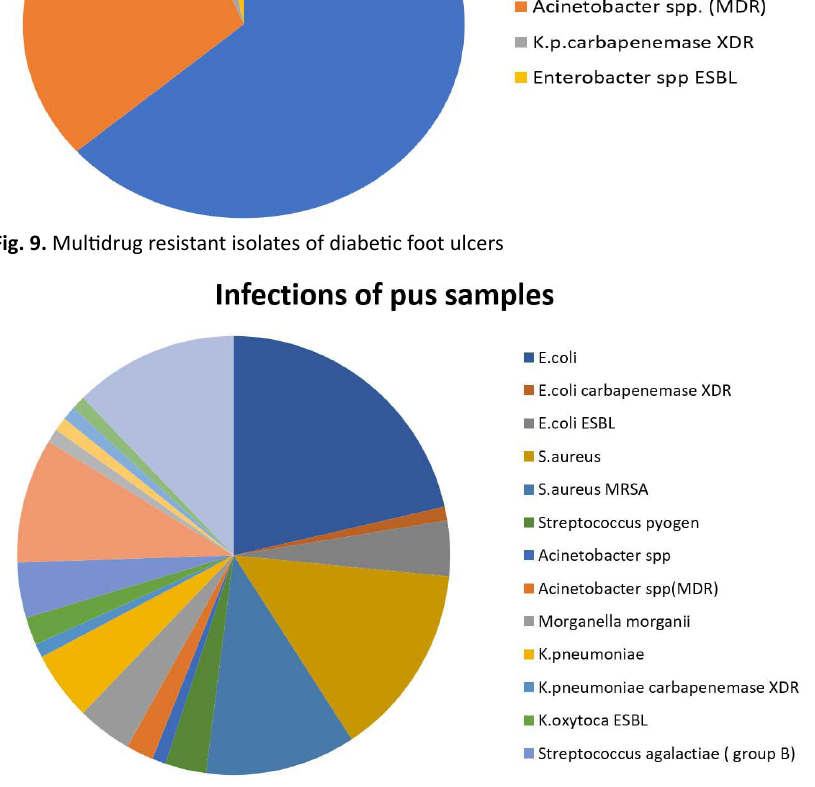
Fig. 10. Pathogenic agents of the pus